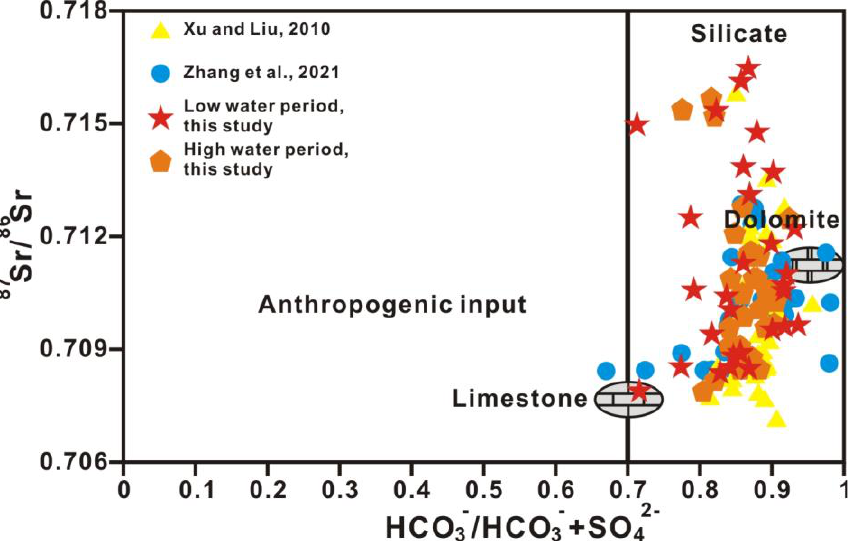
Figure 9. The relationship between 87 Sr/ 86 Sr and HCO 3 − /(HCO 3 − + SO 42 − ) in river water. Rock end-members are from Zhang et al., 2021 [10]. Ref. (Xu and Liu, 2010) is cited in figure [22].